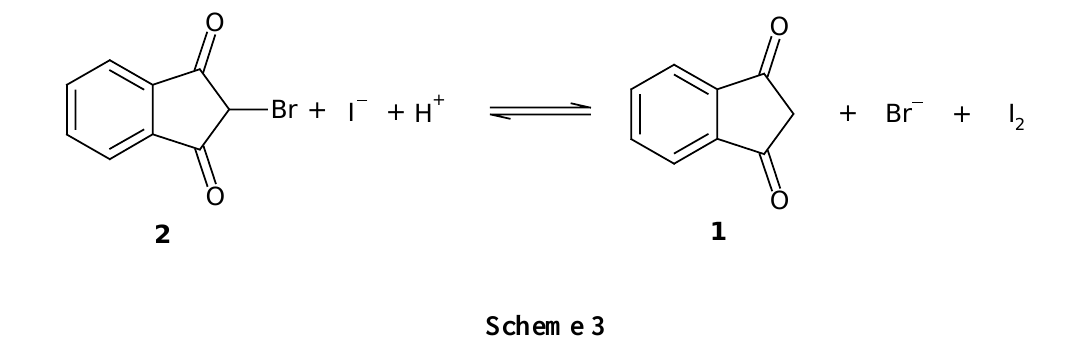
Table 1. Electroanalytical and preparative data.